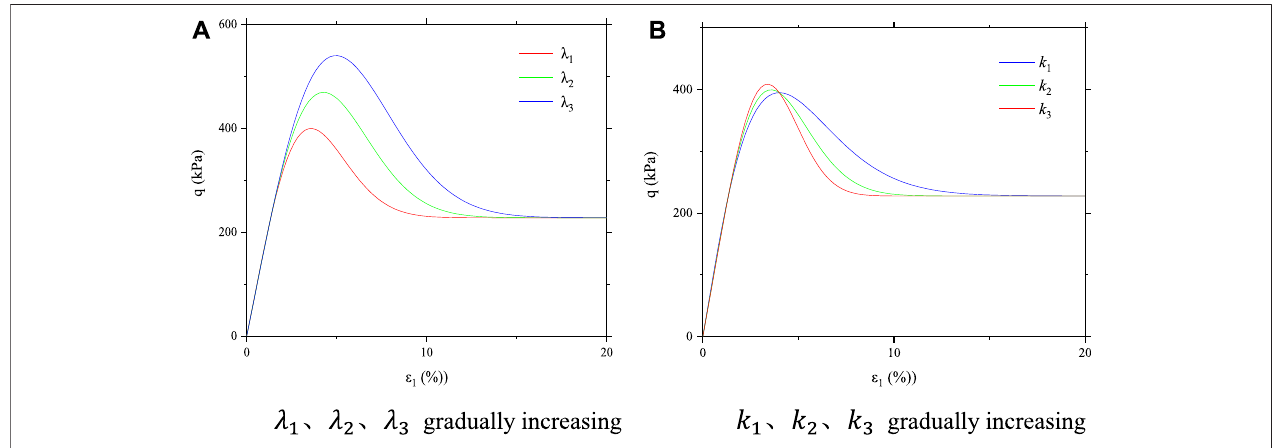
FIGURE 6 | Curves of different λ and. k . (A) λ 1 、 λ 2 、 λ 3 gradually increasing (B) λ 1 、 λ 2 、 λ 3 gradually increasing.